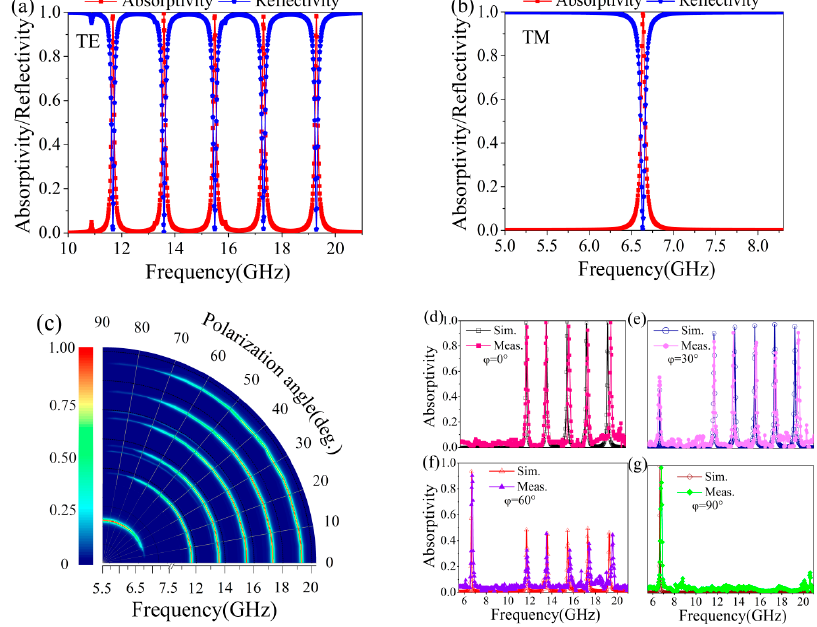
Figure 2. The absorptivity under normal incident for ( a ) TE mode; ( b ) TM mode; ( c ) simulation, and ( d – g ) contrast of simulated and measured results in non-bended situation for different polarization angles.